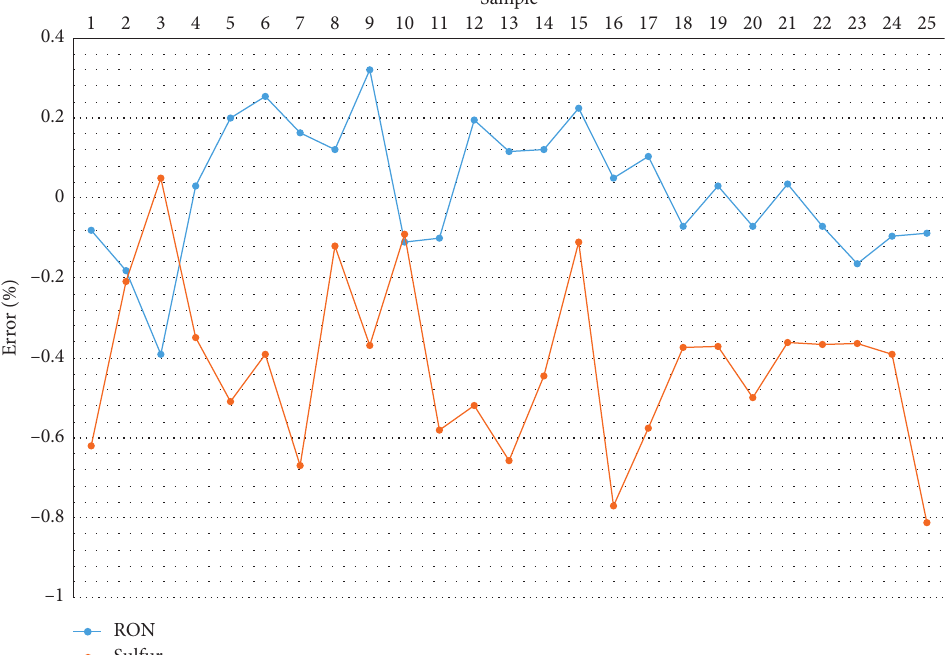
Figure 6: Error percentage between the predicted value and the true value.